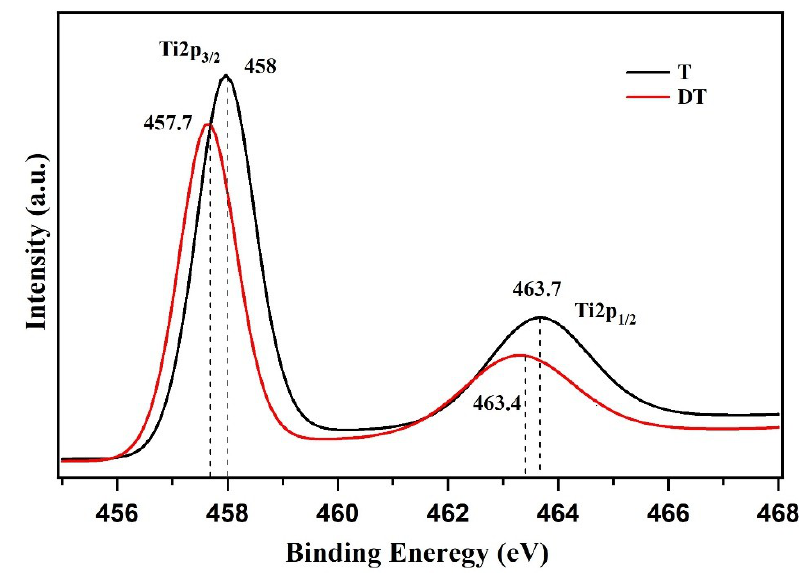
Figure 3. XPS detailed scans in the energy regions of Ti2p for T and DT samples.